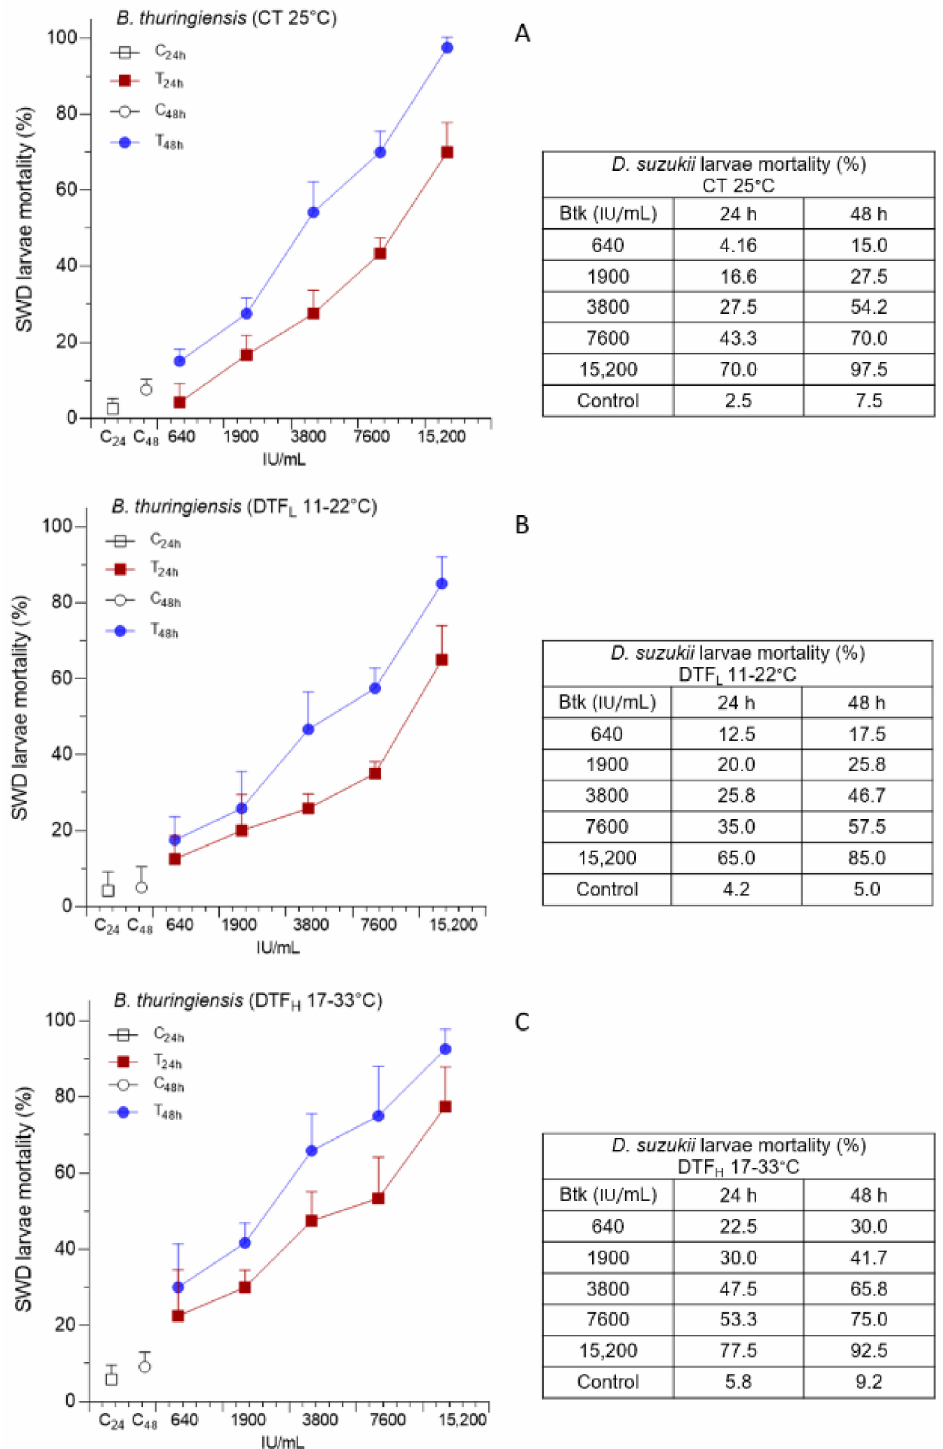
Figure 1. The efficacy of Bacillus thuringiensis var. kurstaki (Btk), at increasing concentrations, was eval- uated as percentage mortality of Spotted Wing Drosophila (SWD) larvae (mean plus standard devia- tion), at 24 and 48 h, under constant temperature—CT 25 ◦ C ( A ), low-temperature fluctuation—DTF L 11–22 ◦ C ( B ) and high-temperature fluctuation—DTF H 17–33 ◦ C ( C